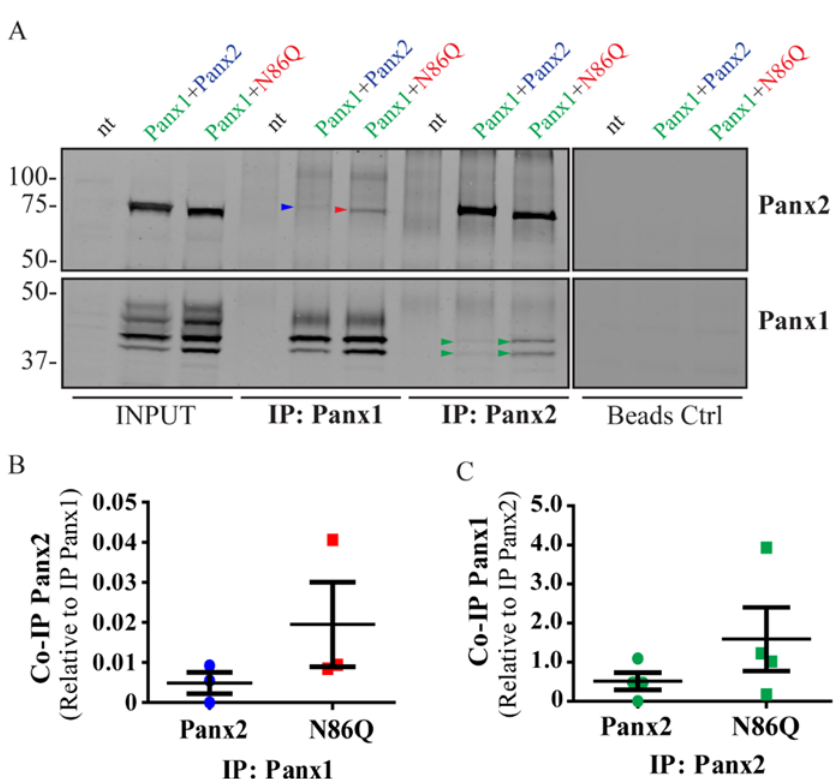
Figure 6. Panx2 glycosylation is not required for the interaction with Panx1 by immunoprecipitation. ( A ) Reciprocal co-immunoprecipitation (co-IP) experiments showed that both Panx2 and N86Q co-IP in a complex with overexpressed Panx1 in HEK293T cells. Colored arrowheads denote bands of co-IP proteins detected in WB. ( B , C ) Quantitative analysis (see Materials and Methods Section 4.8) of co-IP shows that the interaction of N86Q with Panx1 is not significantly different ( p > 0.05, N = 4) than with Panx2, and in both cases the complexes only involved the lower glycosylated species of Panx1 (Gly-0 and Gly-1). Beads Ctrl denote control IPs done in parallel without antibodies. Protein sizes in kDa. Due to the lack of available antibodies from different species to perform double immunolabeling of both pannexins, we used C-terminal FLAG-tagged Panx2 and N86Q that were co-expressed with Panx1 in HEK293T cells. Confocal imaging of Panx2-FLAG or N86Q-FLAG co-expressed with